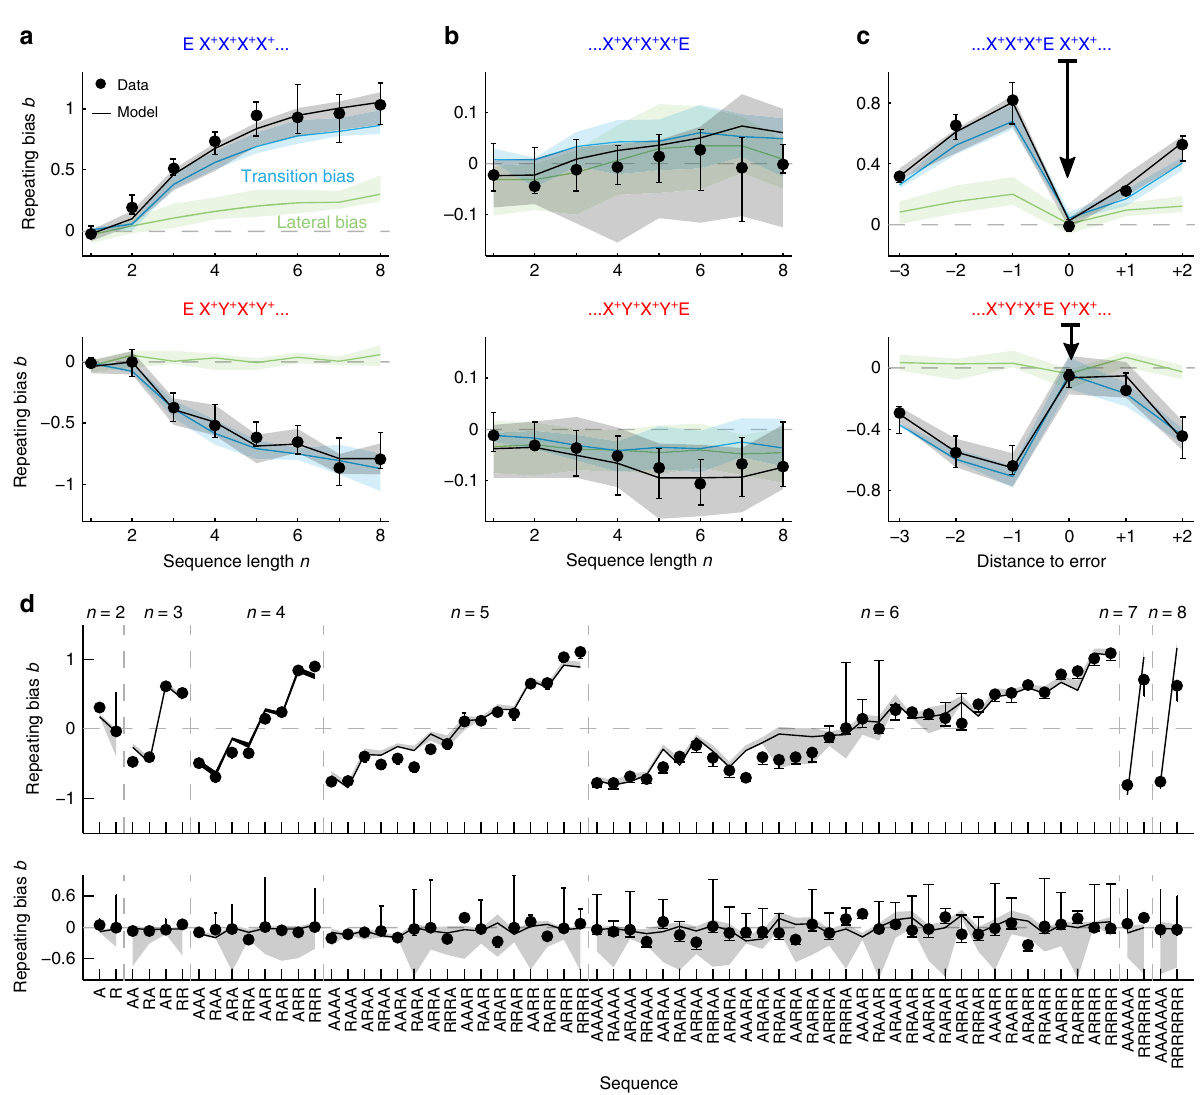
Fig. 7 Generative model simulation compared to experimental data. Comparison between experimental data (dots) and model simulation (black curves) showing the repeating bias b for different trial sequences. In the model, b was decomposed into the transition bias contribution (blue curves) and lateral bias contribution (green curves). a Repeating bias b versus number n of correct repetitions (top) or alternations (bottom). Data are the same as the color curves in Fig. 2e. b Repeating bias versus n after a repetitive (top) or alternating sequence (bottom) terminated by an error (as black curves in Fig. 2e). Notice the different range in the b axes compared with a . c Repeating bias for sequences with an error E fl anked by correct repetitions (top) or alternations (bottom). The bias b is given as a function the trial distance to the error response (distance zero represents b after the error). d Repeating bias for all sequences made of n ≤ 8 repetitions (R) and alternations (A). Top panel shows correct sequences while bottom panel shows correct sequences terminated by an error. In all panels, data and model show median across n = 10 rats. Error bars and shaded areas show fi rst and third